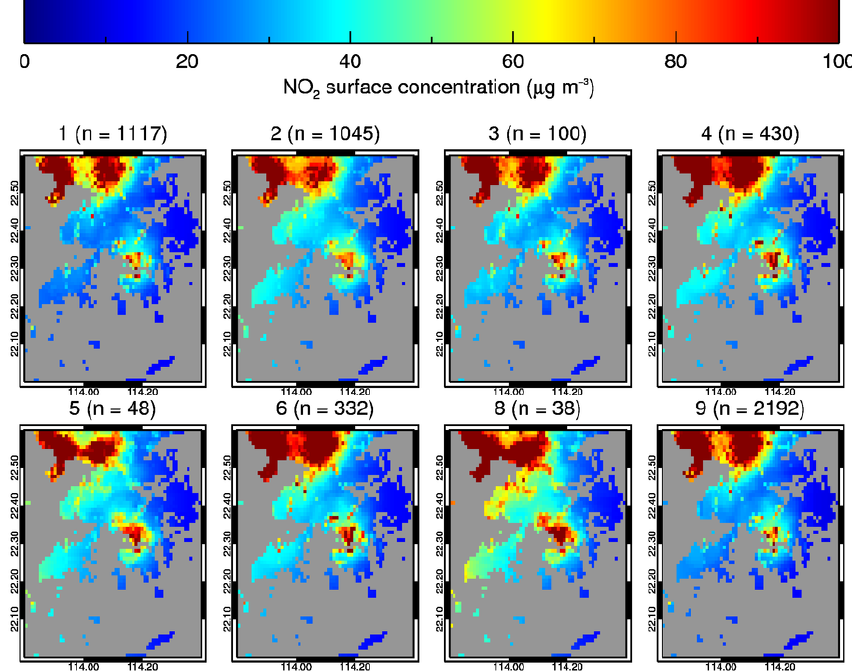
Figure 3. The mean surface NO 2 concentration predicted by each of the models listed in Table 2 for 2007–2012. Each plot also shows the number of cloud-free days from which the models could be